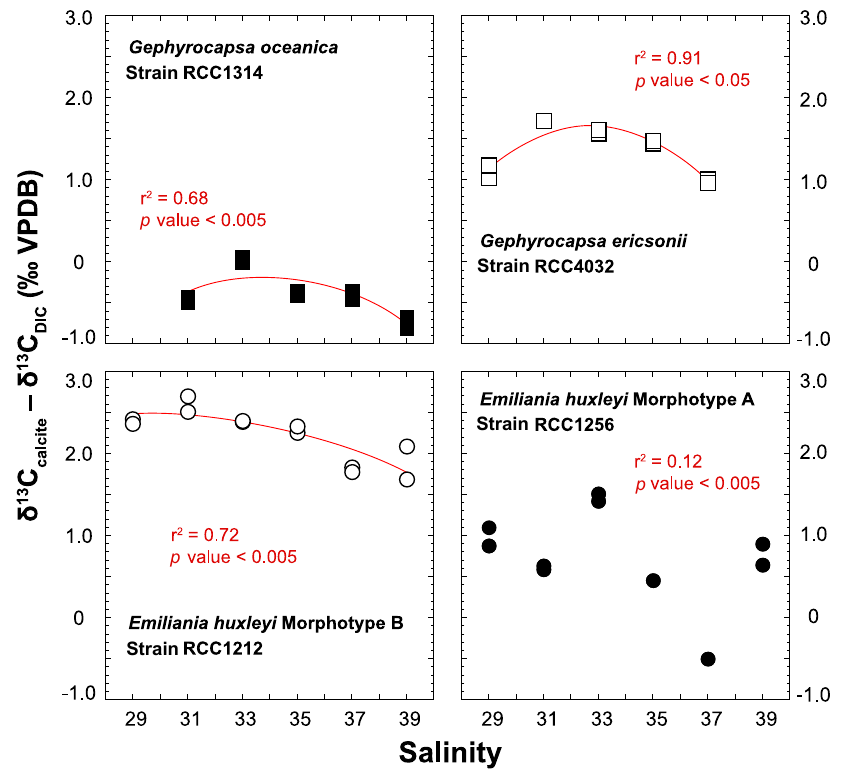
Figure 6. Effect of ambient salinity on the carbon isotope composition of coccolith calcite. There is an influence of salinity, or a parameter itself influenced by salinity (growth rate) on the stable carbon isotope composition of the coccoliths. The is a general decrease in δ 13 C values with salinity, particularly well expressed on the Sal33–39 spectrum. RCC1256 E. huxleyi shows an appreciable spread in the data without a clear correlation between salinity and δ 13 C